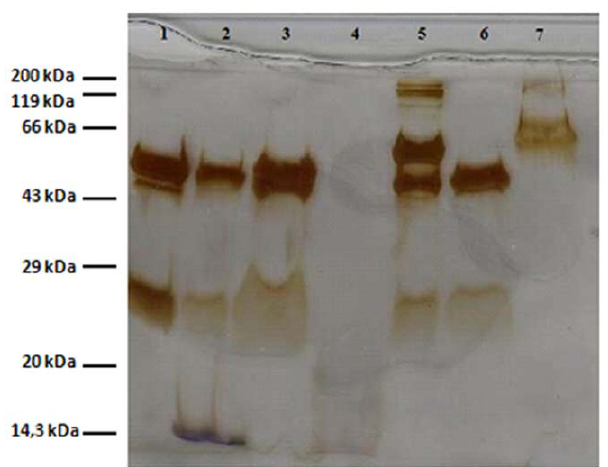
Figure 4. Micrograph of crystalline mAb04c crystallized from clarified culture supernatant. Crystallization condition: sitting drop. Reservoir: 0.1 M imidazol, 0.2 M calcium acetate, 9% w/v PEG 8000. 20 m L clarified culture supernatant (8.3 mg/ml mAb04c) plus 20 m l